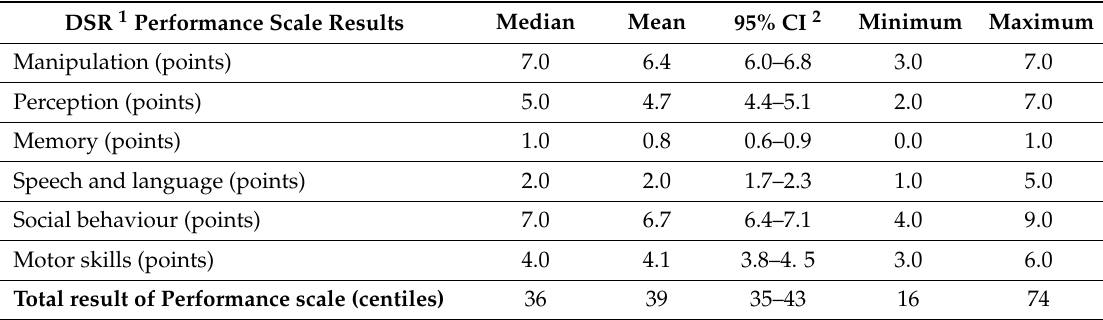
Table 4. The results of the infant psychomotor assessment at the sixth month of